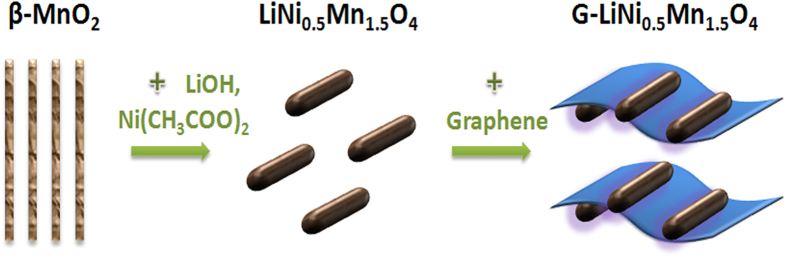
Schematic illustration of the design of the hybrid LiNi0.5Mn1.5O4-graphene electrode material.